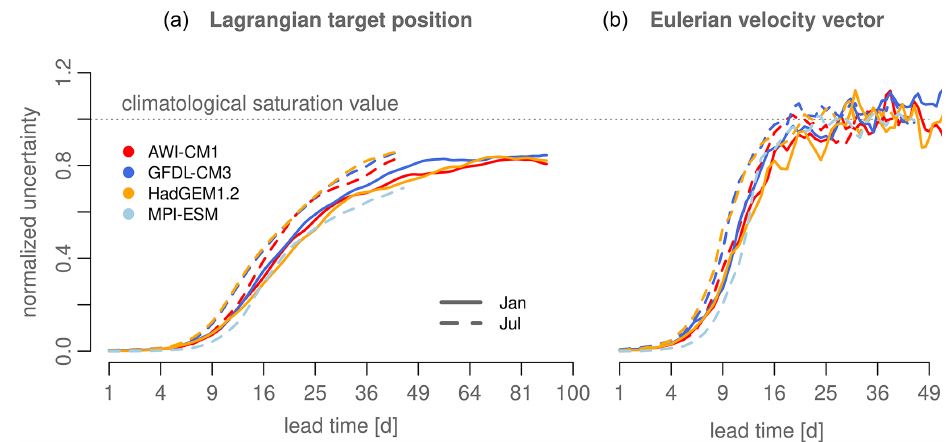
Figure 7. (a) Temporal evolution of normalized uncertainty in Lagrangian target position for all models, spatially averaged on the com- mon subset of initial positions. Solid lines show the January initializations and dashed lines July. The horizontal dashed line indicates the climatological saturation value. Please note the square root horizontal axis. (b) The same as (a) but for the Eulerian ice